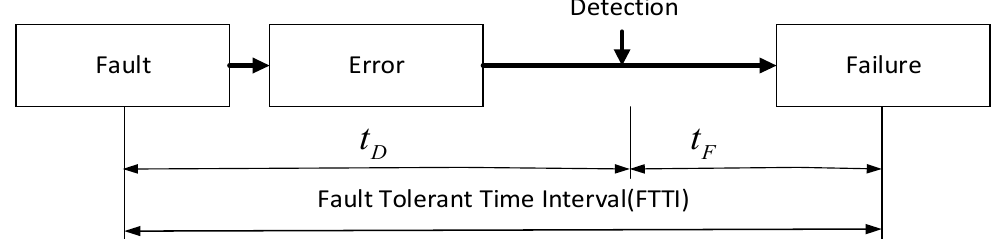
Figure 3. Fault-error failure chain and time definitions: t D , t F and FTTI.